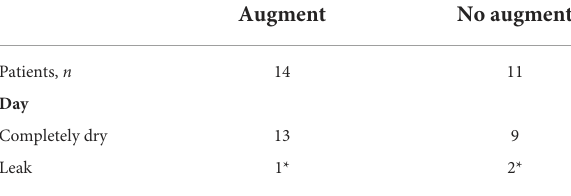
TABLE 3 Continence per urethra stratified by concurrent